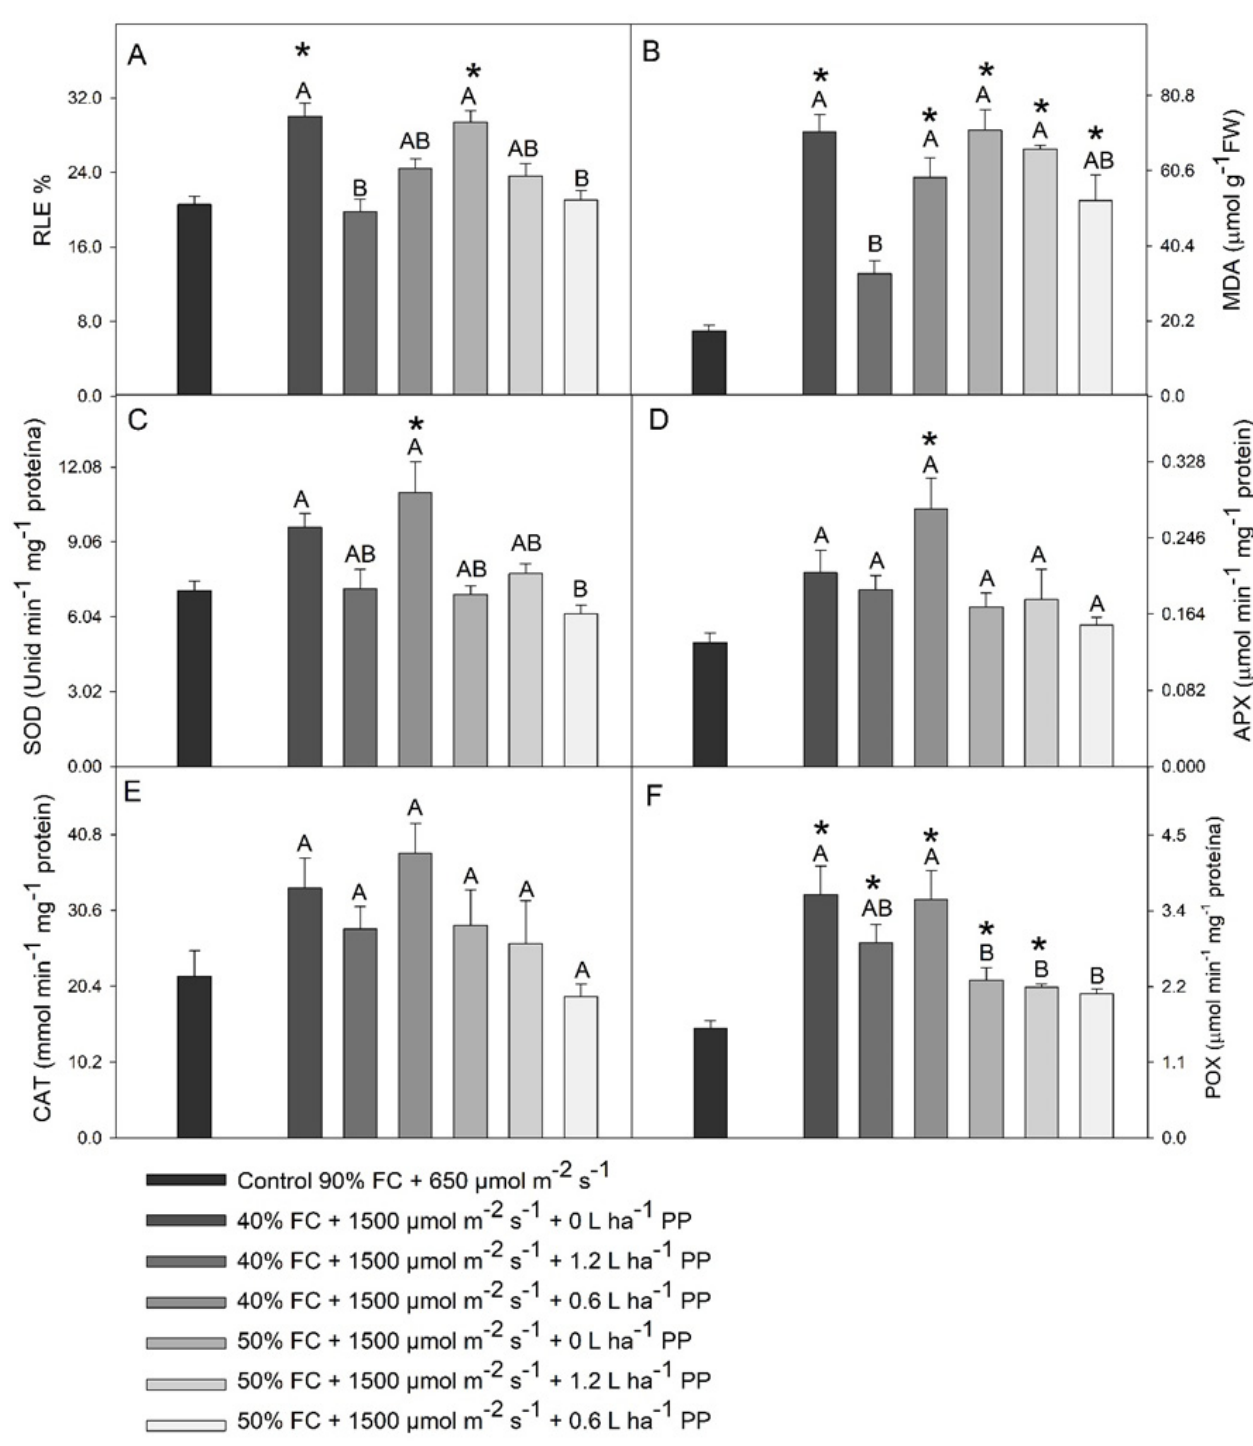
Figure 5. Rate of electrolyte leakage (REL; ( A )), malonaldehyde concentration (MDA; ( B )), activities of superoxide dismutase (SOD; ( C )), ascorbate peroxidase (APX; ( D )), c € lase (CAT; ( E )), and peroxidase (POX; ( F )) of soybean plants treated with doses of potassium phosphite (PP) and exposed to water deficit + high irradiance for 12 days. Bars represent mean ± SEM ( n = 5). Means followed by an asterisk (*) differ from control by Dunnett’s test ( p < 0.05). Means followed by the same letter did not differ among stress treatments, as determined by Tukey’s test ( p <